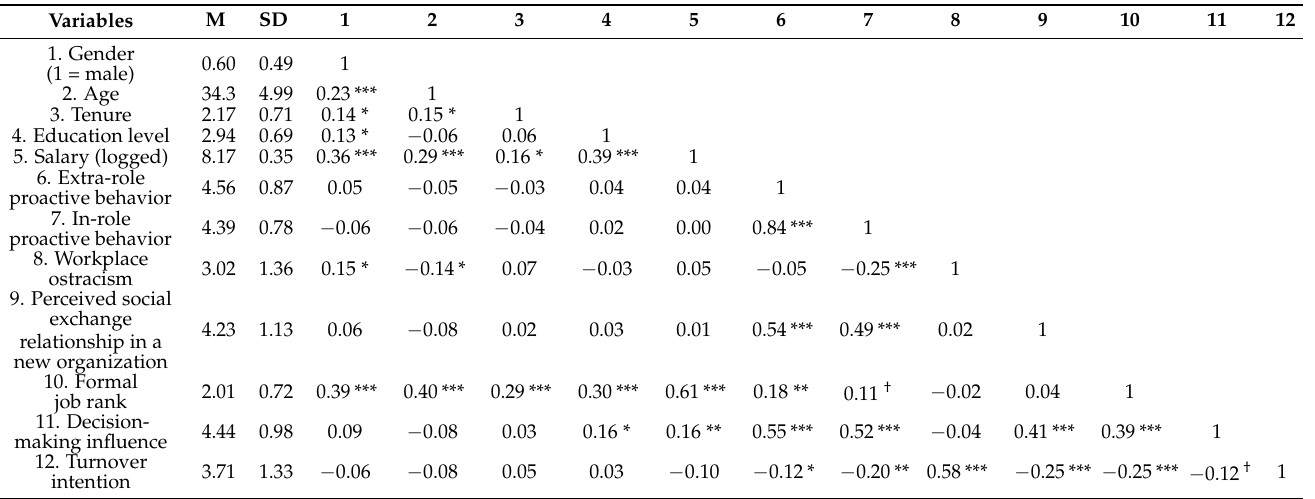
Table 2. Means, standard deviations, and correlation